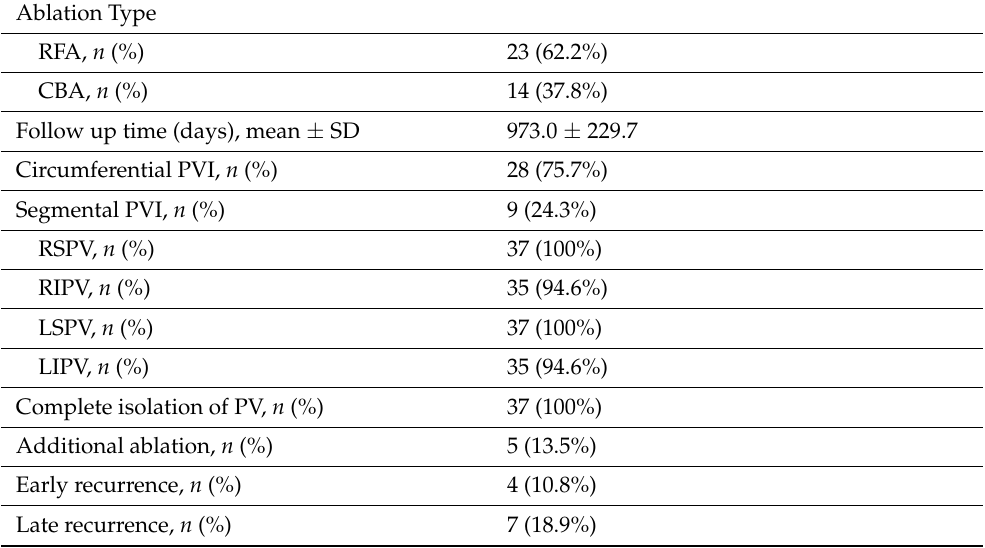
Table 2. Ablation results and